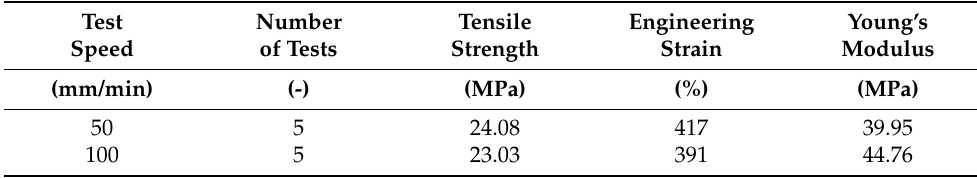
Table 1. Strength properties of a polyurea